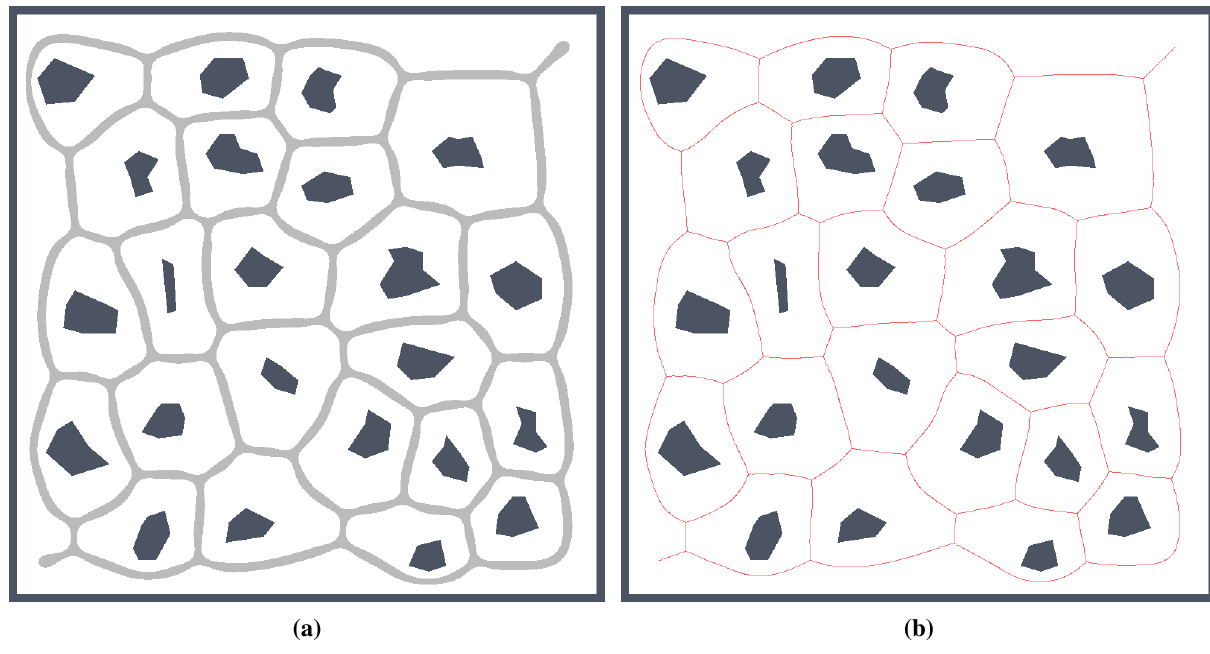
Figure 8. Example of found skeleton (Voronoi diagram) by the RD-based computational model for the pothole environment: ( a ) light gray structure; ( b ) and its one pixel width skeleton shown in